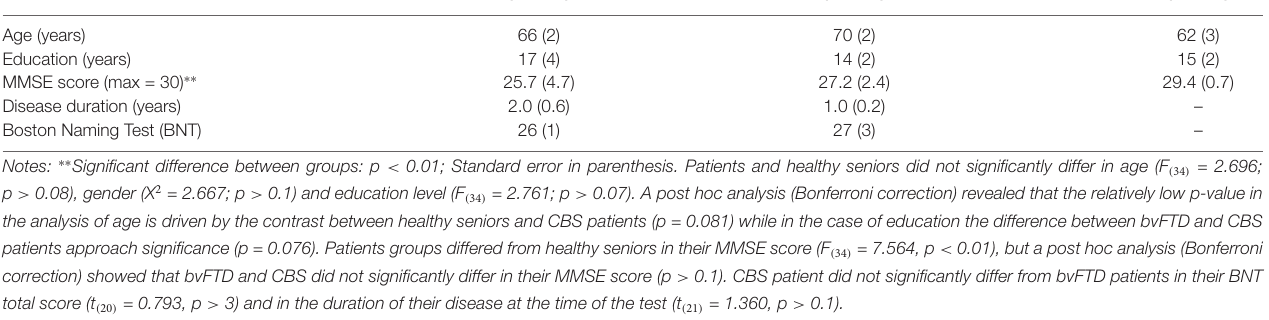
TABLE 1 | Mean ( ± SEM) demographic and neuropsychological data for patient and control groups. Demographic/Clinical